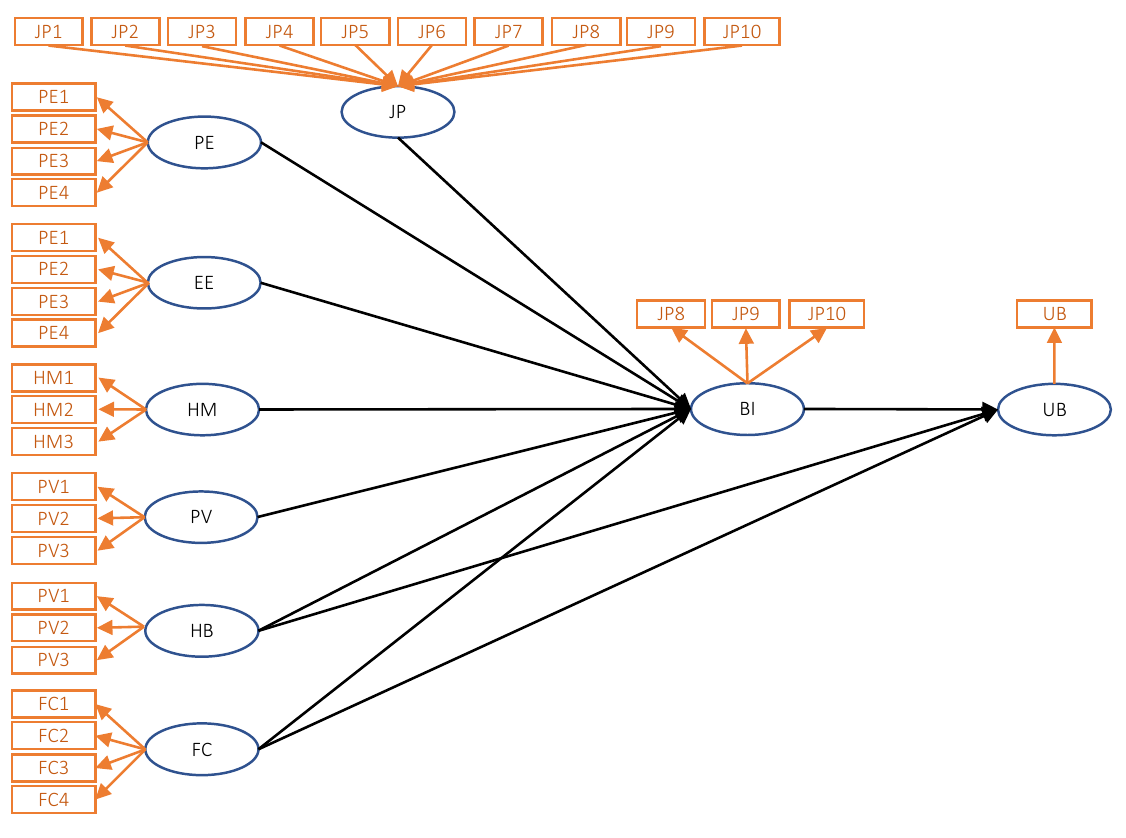
Figure 1. The model based on